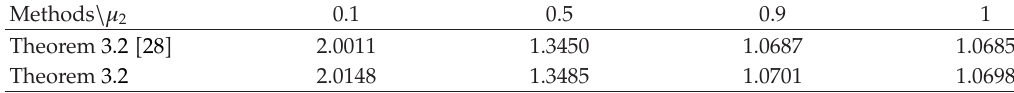
Table 5: Calculated MAUBs τ